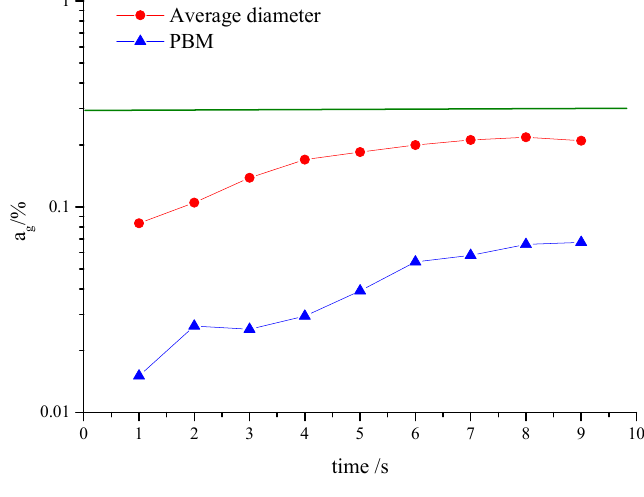
Figure 13. Variation of gas holdup.